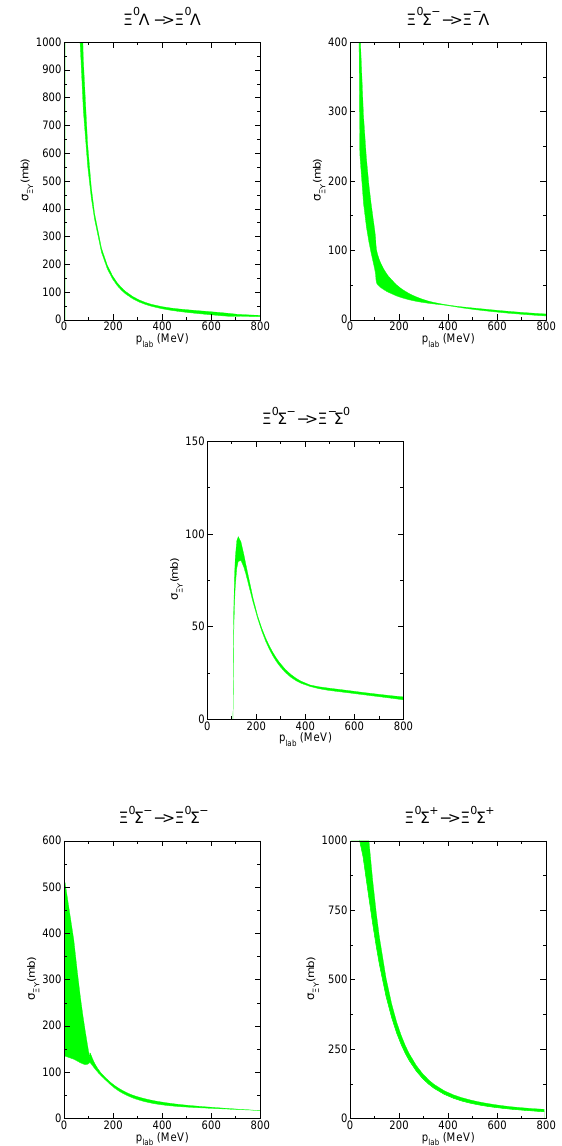
Fig. 4. Total cross sections for various reactions in the strangeness S = 3 sector as a function of p lab . The shaded band shows the − chiral EFT results for variations of the cut-o ff in the range Λ = 550 . .. 700